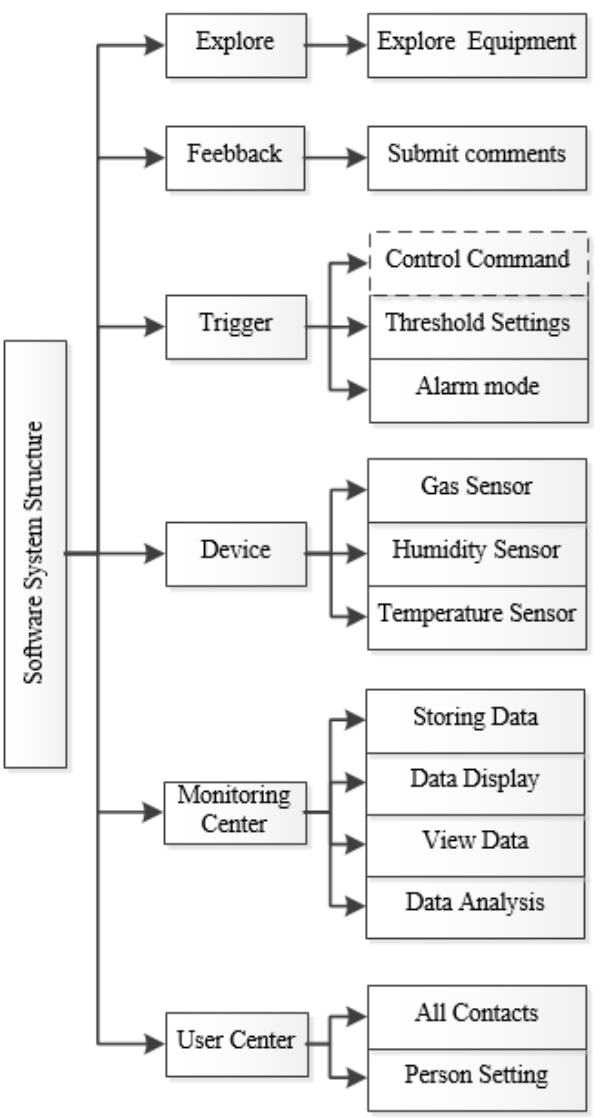
Figure 6. Functional design of software for managers.